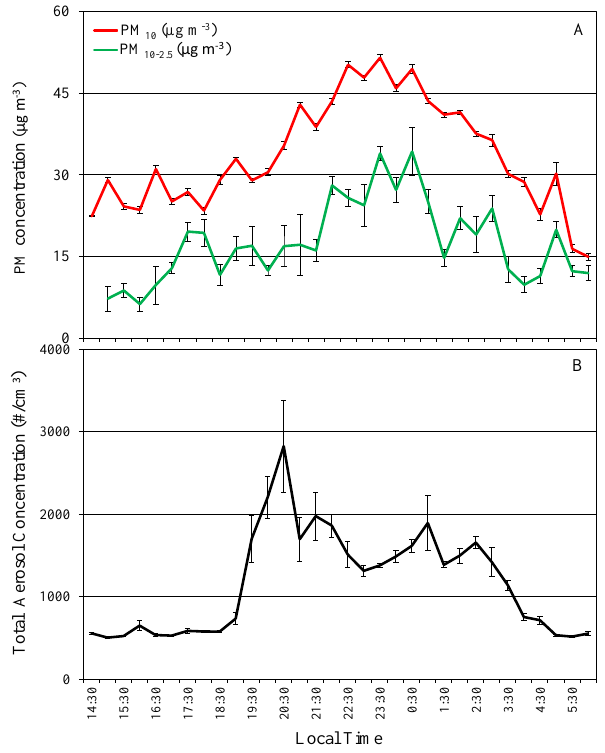
Figure 10. PM 10 (in red) and PM 10 − 2 . 5 concentration (in green) and aerosol total concentration (in black), as measured during 1–2 May 2010. The data are averaged over 30min and the bars represent the standard deviation. The bonfires started around 19:00LT and ended around 03:00LT the next morning as rain began to